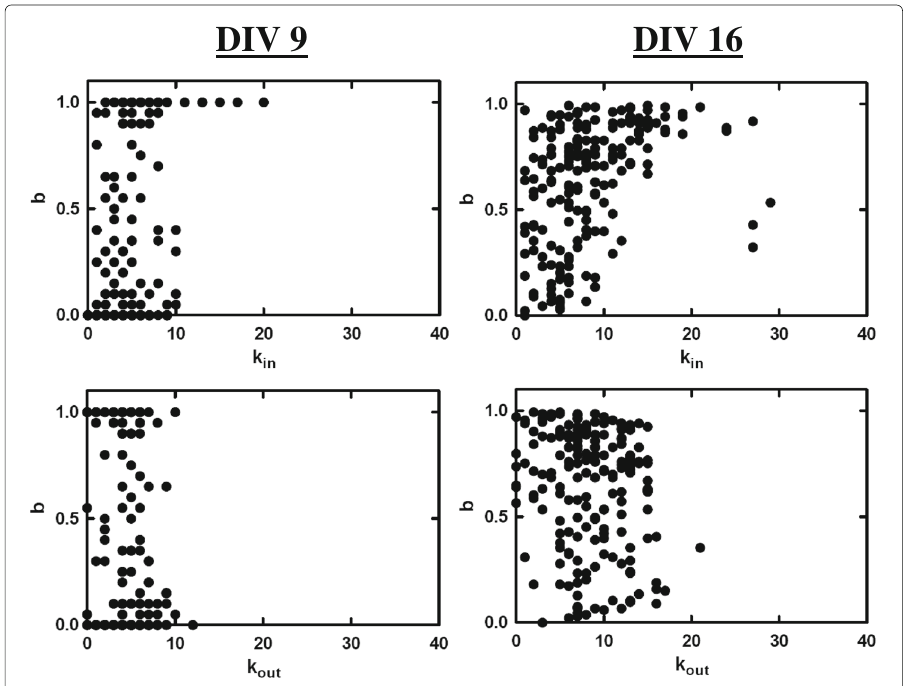
Fig. 6 Bursting parameter vs. in-degree (out-degree) plotted for each neuron in the same two networks shown in Fig. 4